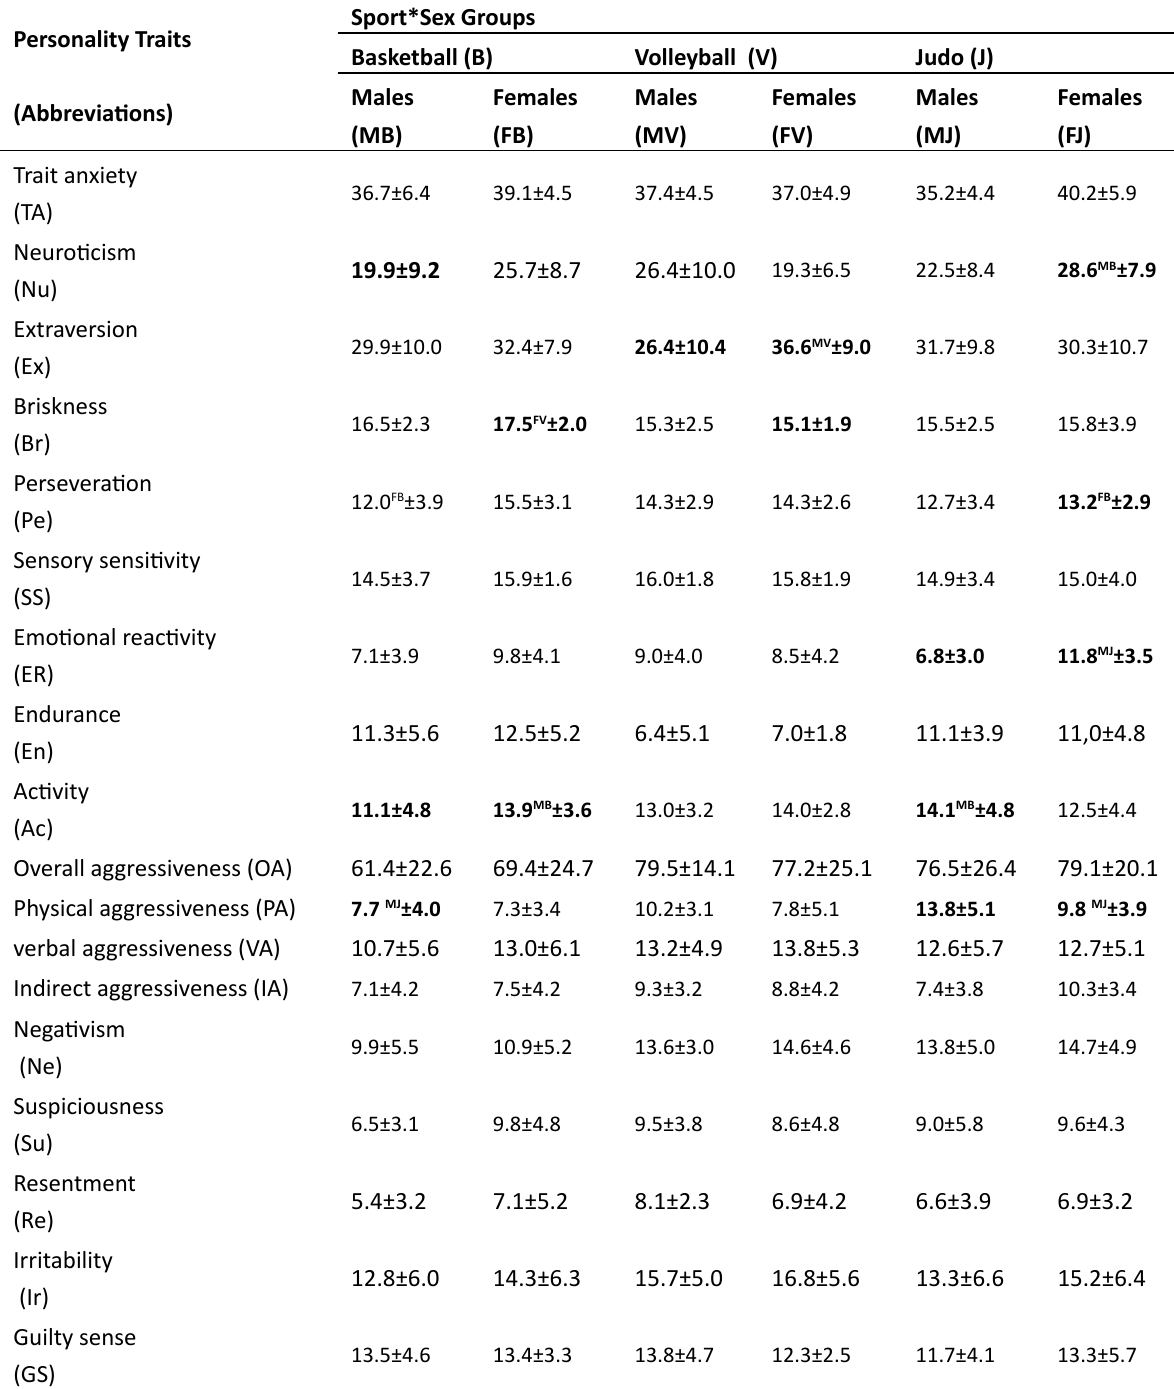
Table 1. Data of personality traits scores in six groups *n=24, two sexes *n=72 and three sports*n=48. Between- groups comparisons of the variables by sexes and sports.